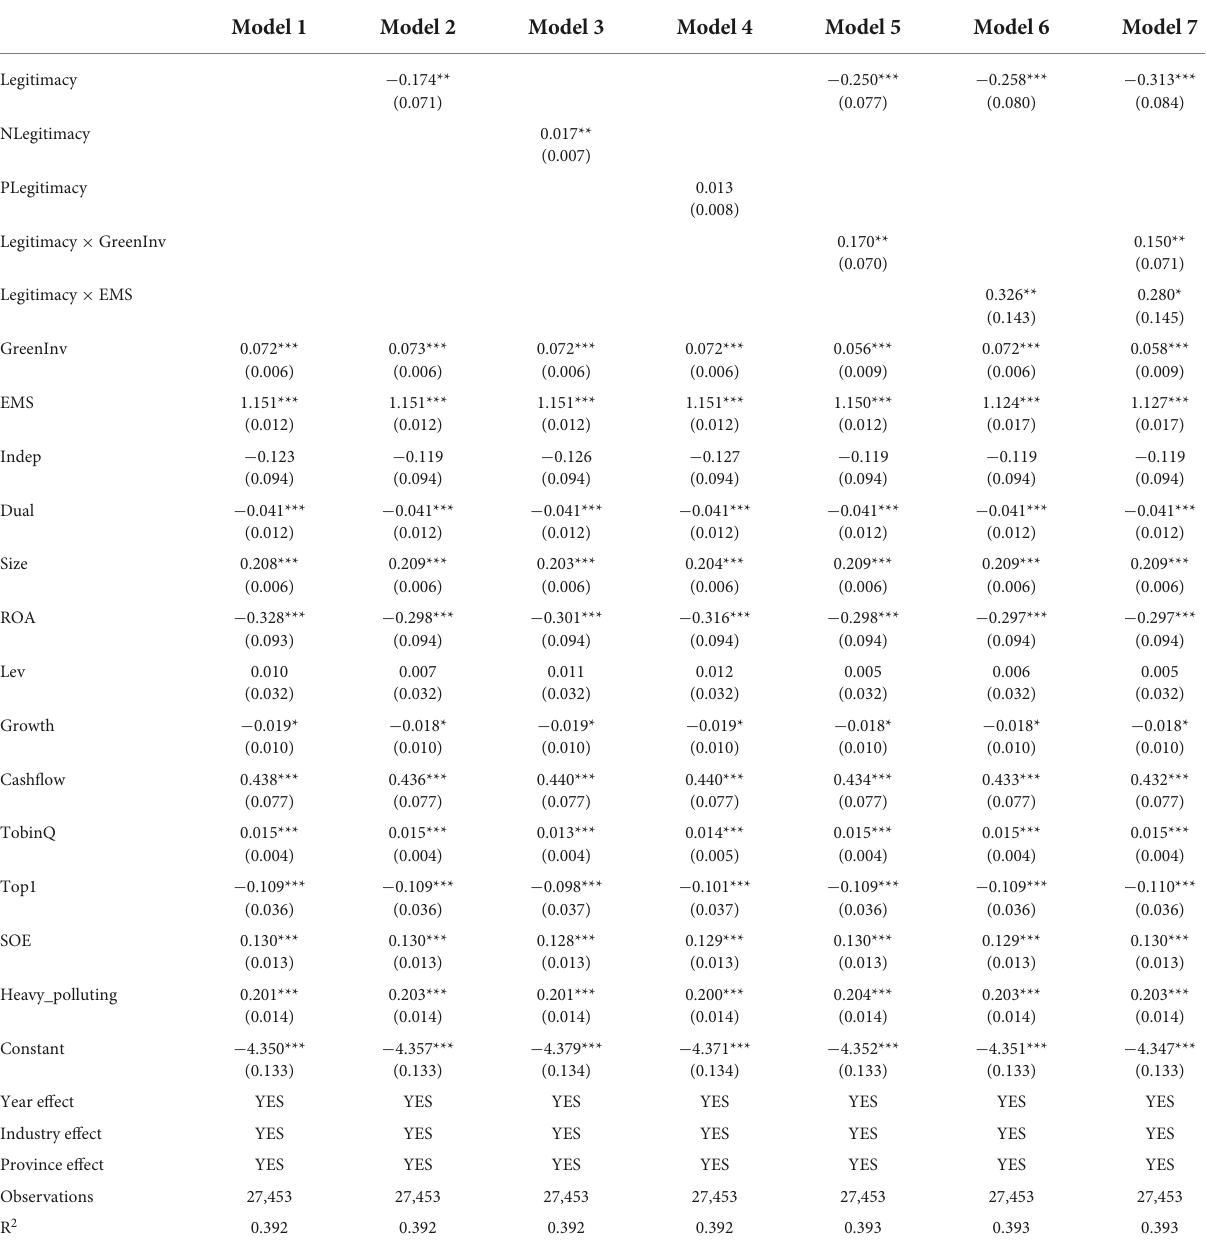
TABLE 4 Estimates for carbon information